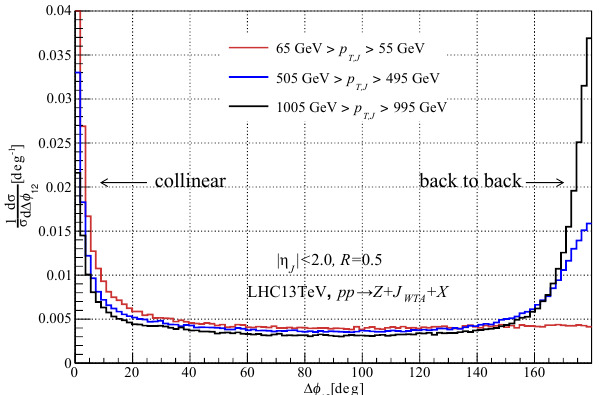
Figure 14. The distribution in the azimuthal angle ∆ φ 12 between the two final-state partons at NLO. For p T,J . m V there is a collinear singularity at ∆ φ 12 → 0 , while for p T,J (cid:29) m V there is also a collinear singularity at ∆ φ 12 → 180 ◦ from a Z boson emitted from a dijet partonic